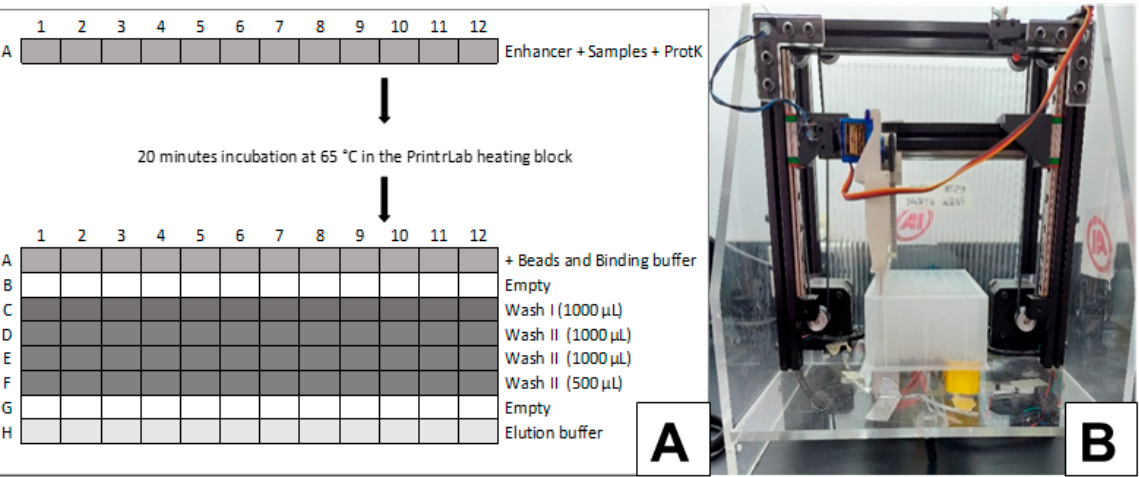
Figure 1. A plate-layout scheme for the PrintrLab DNA-extraction procedure. Blood samples, lysis buffer and magnetic particles are loaded in row ( A ). Subsequently, the DNA bound to the magnetic particles is captured and transferred to successive rows for the washing steps and the final DNA elution step. All steps are performed with agitation and slow capture of the beads. ( B ) PrintrLab extraction device.